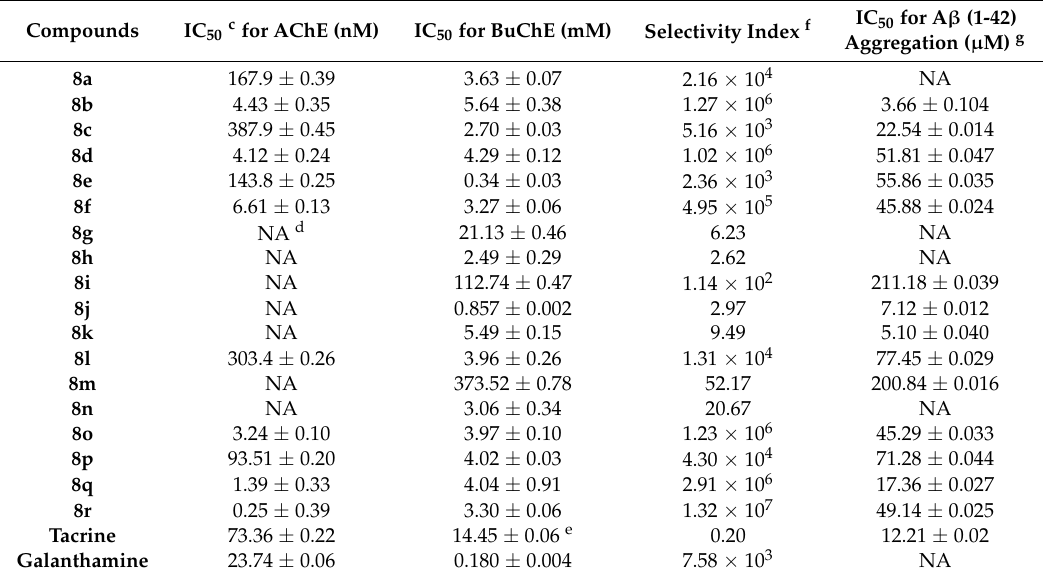
Galanthamine a Data was expressed as mean ± SEM of at least three independent experiments. b All tested compounds were soluble at a final concentration in each assay. c IC 50 , inhibitor concentration for 50% inactivation of AChE. d No potent inhibitory activity. e Unit of nM (nanomolar). f Selectivity index = IC 50 (BChE)/IC 50 (AChE). g The thioflavin-T fluorescence method was used and the measurements were carried out in the presence of 0, 5, 10, 20, 50, 100,